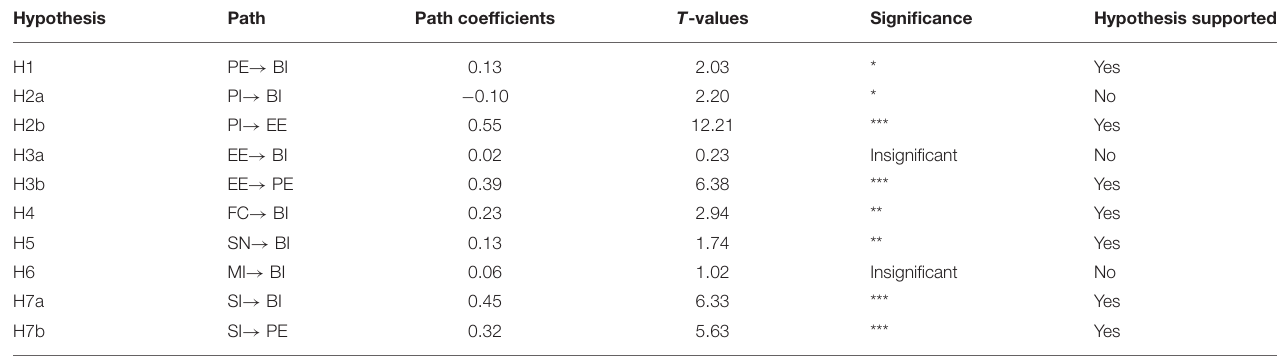
TABLE 8 | Path coefficients and hypothesis validation results.